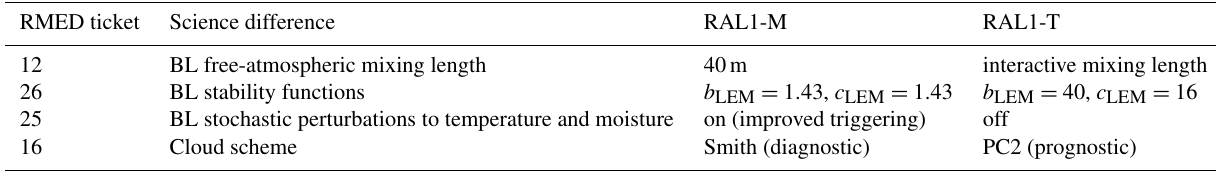
Table 2. RAL1-M and RAL1-T differences.